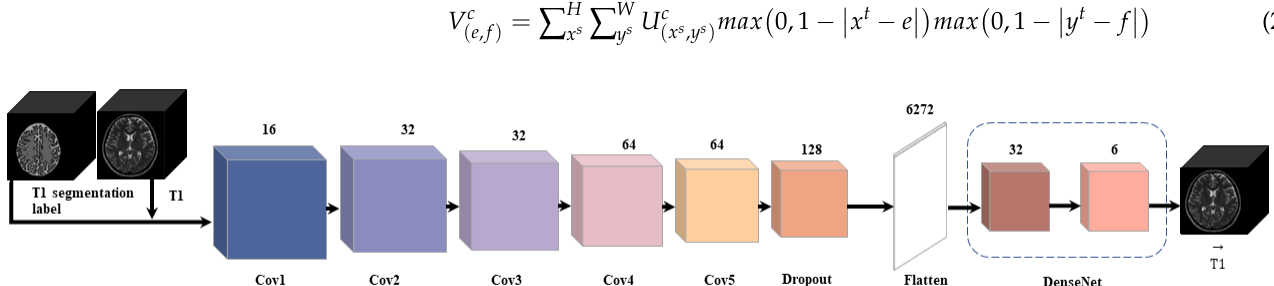
Figure 3. The detailed construction of our STN.